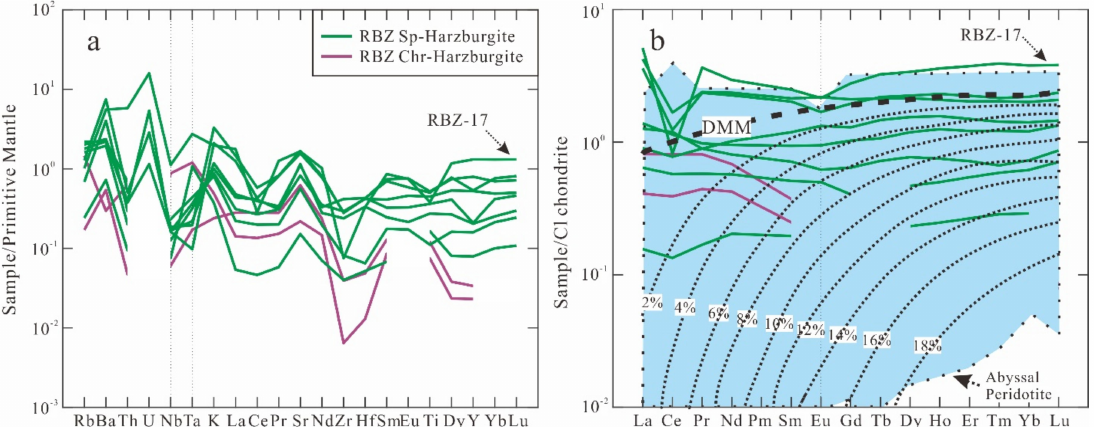
Figure 5. ( a ) Whole-rock primitive mantle (PM)-normalized trace element patterns and ( b ) chondrite normalized REE patterns from the Raobazhai harzburgites. The DMM and partial melting pattern diagrams are from [24]; and the abyssal peridotite data is from